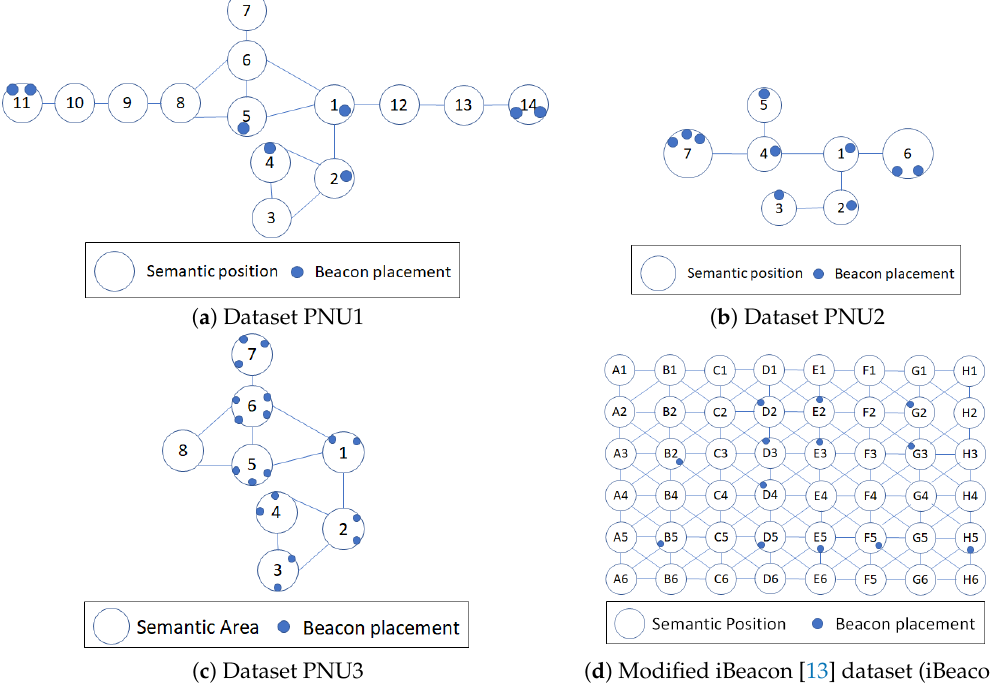
Figure 8. Semantic graphs of the collected datasets